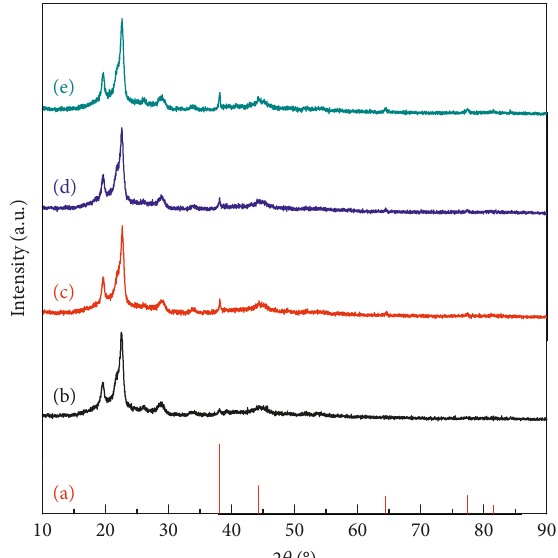
Figure 8: (a) Calculated XRD peaks of standard silver metal (JCPDS no. 04-0783) and the observed XRD patterns of (b) 3AgCB-PBS, (c) 5AgCB-PBS, (d) 10AgCB-PBS, and (e) 15AgCB-PBS